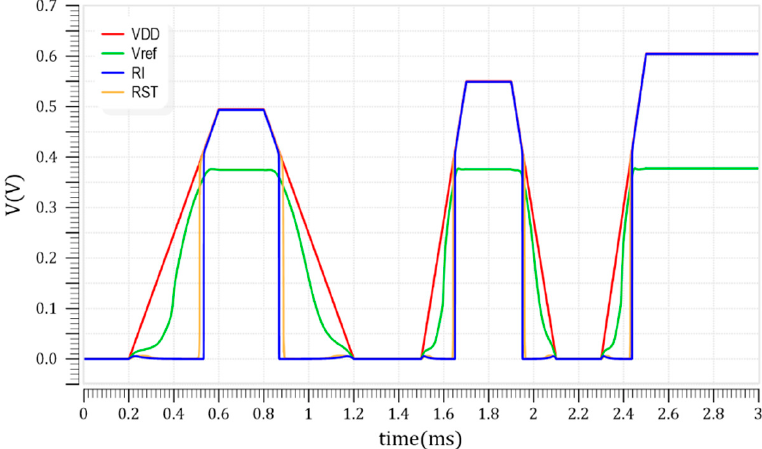
Figure 13. Simulation results for BGR#3 (65 nm, 550 mV) in typical temperature (27 °C), 550 mV supply voltage, ±10%.